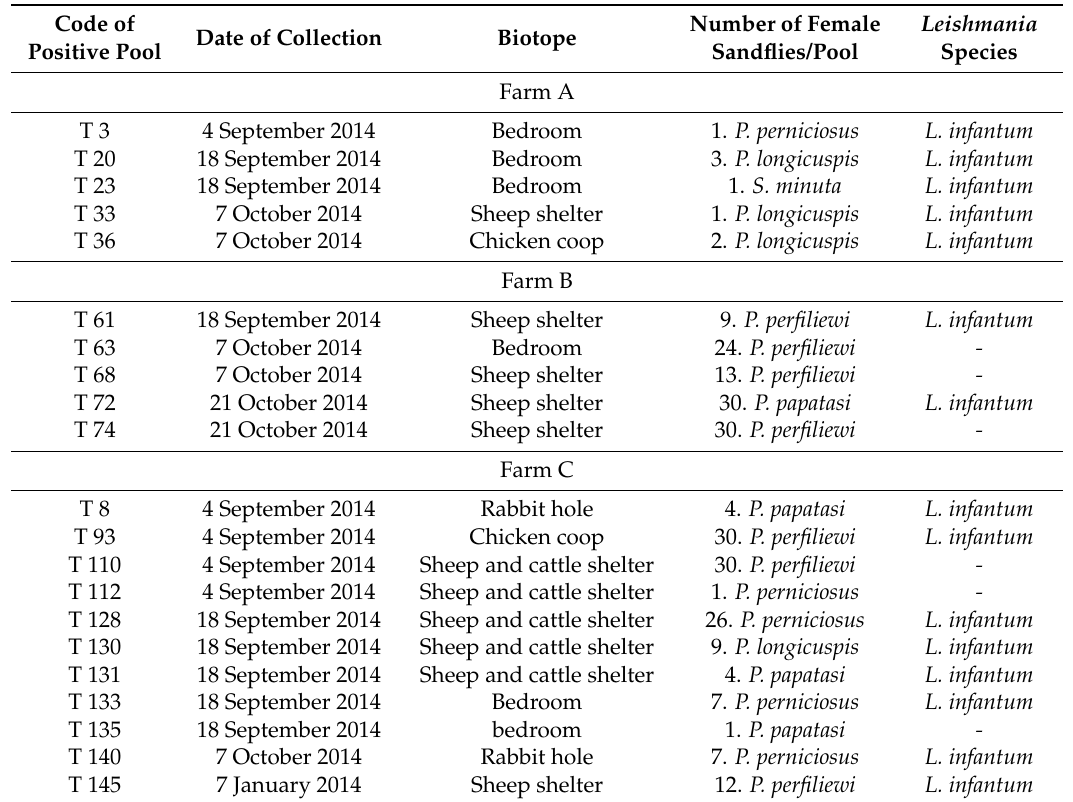
Table 1. Detection of Leishmania infantum DNA in sand flies according to